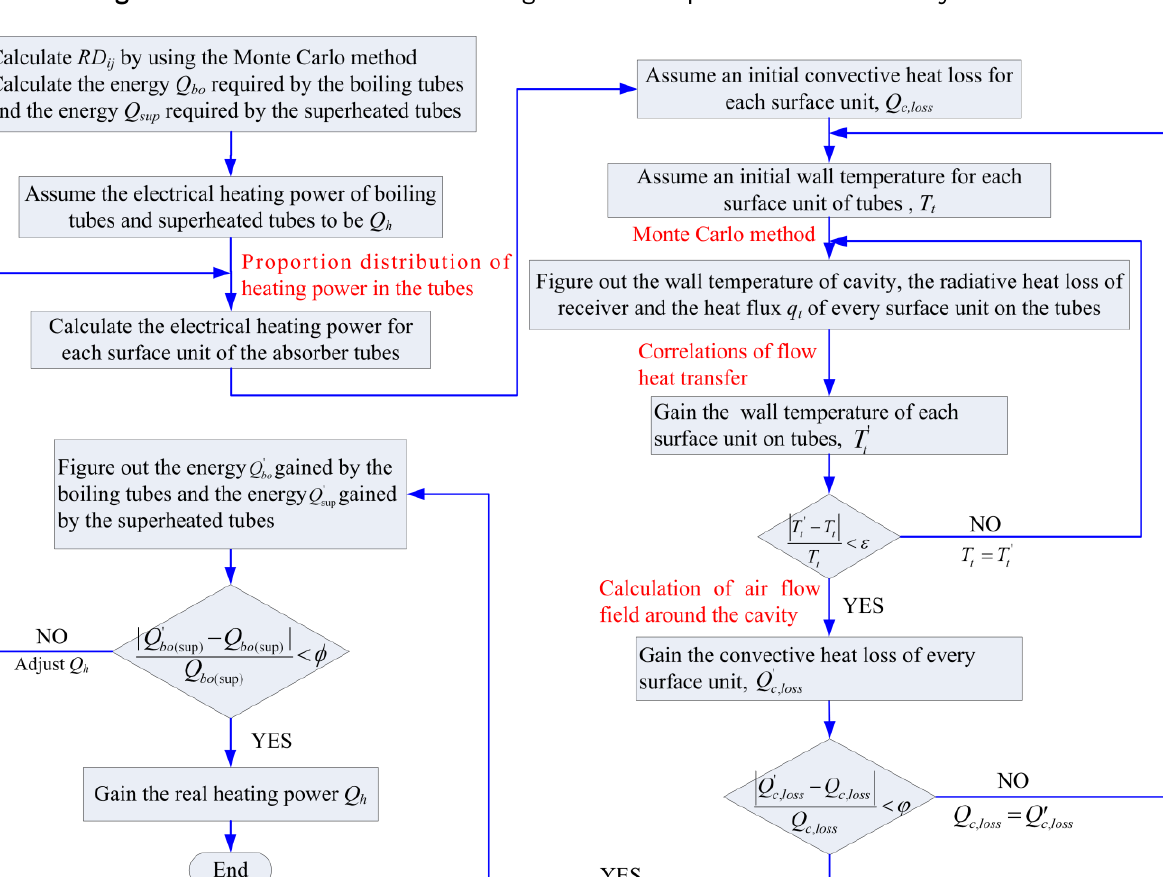
Figure 10. Flow chart for calculating the thermal performance of cavity